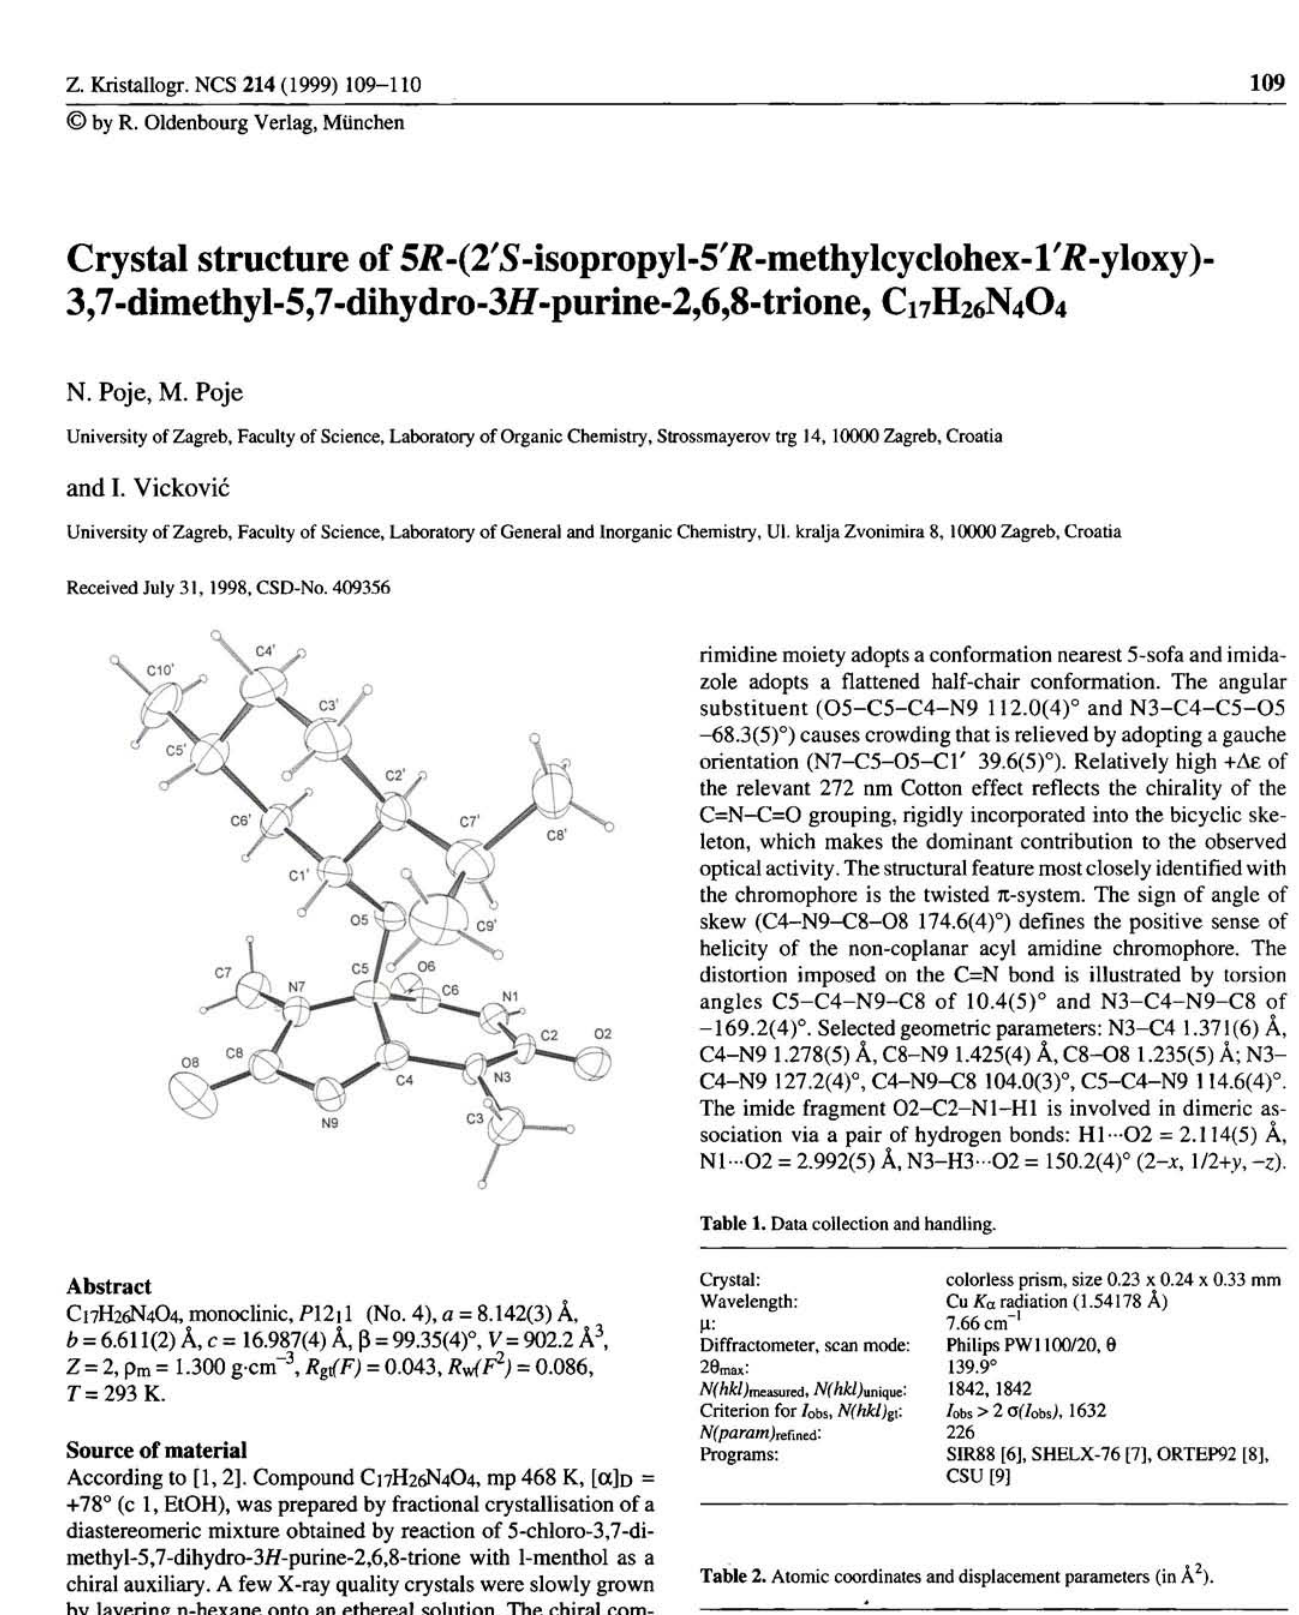
Table 2. Atomic coordinates and displacement parameters (in À 2